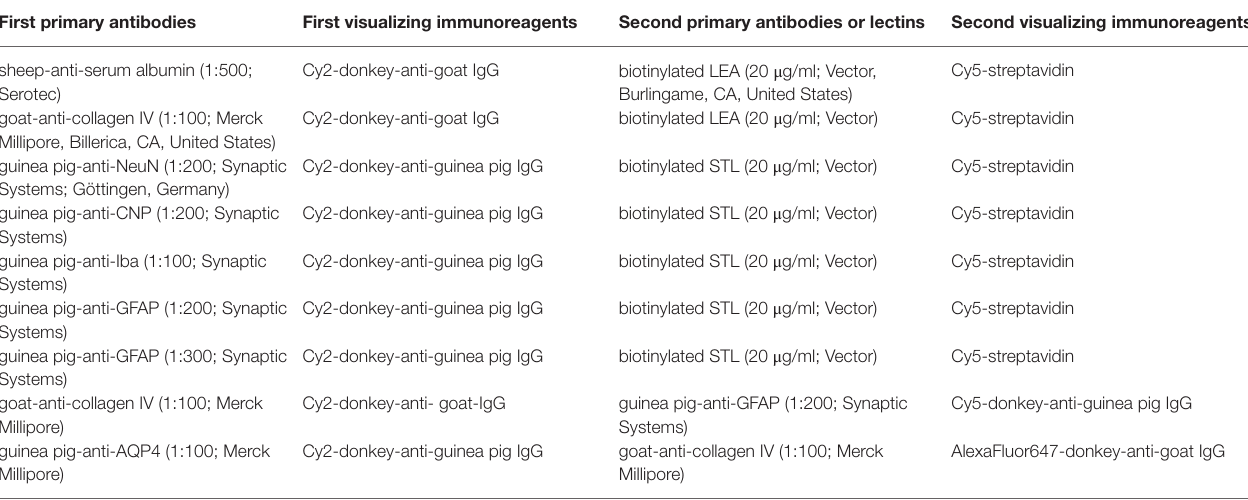
TABLE 1 | Triple fluorescence staining: marker combinations concomitantly applied with Cy3-stained